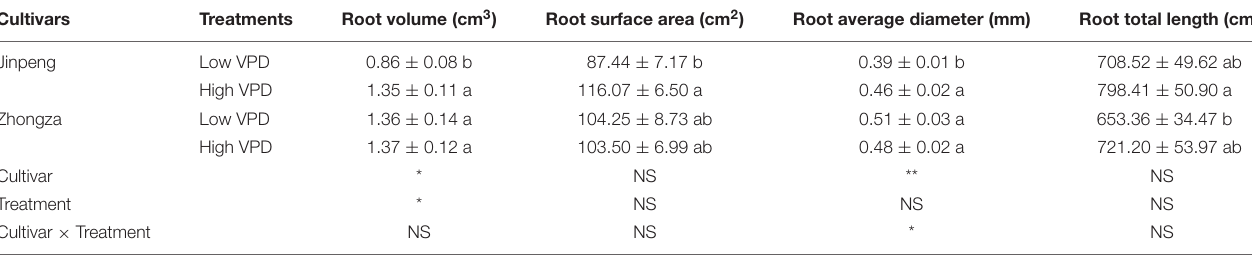
TABLE 2 | Root volume, surface area, average diameter, and total length for two tomato cultivars, Jinpeng and Zhongza, grown under low (1.1–1.5 kPa) and high (2.2–2.6 kPa) VPD.